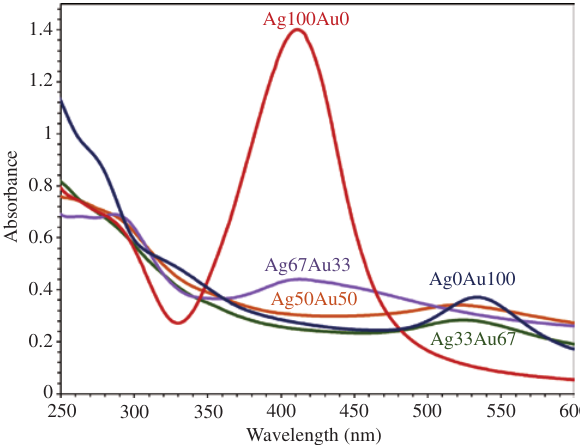
Figure 1: Ag (Ag100Au0), Au (Ag0Au100) monometallic and Ag67Au33, Ag50Au50, Ag33Au67 bimetallic nanoparticles prepared by Cetraria islandica (L.) Ach.